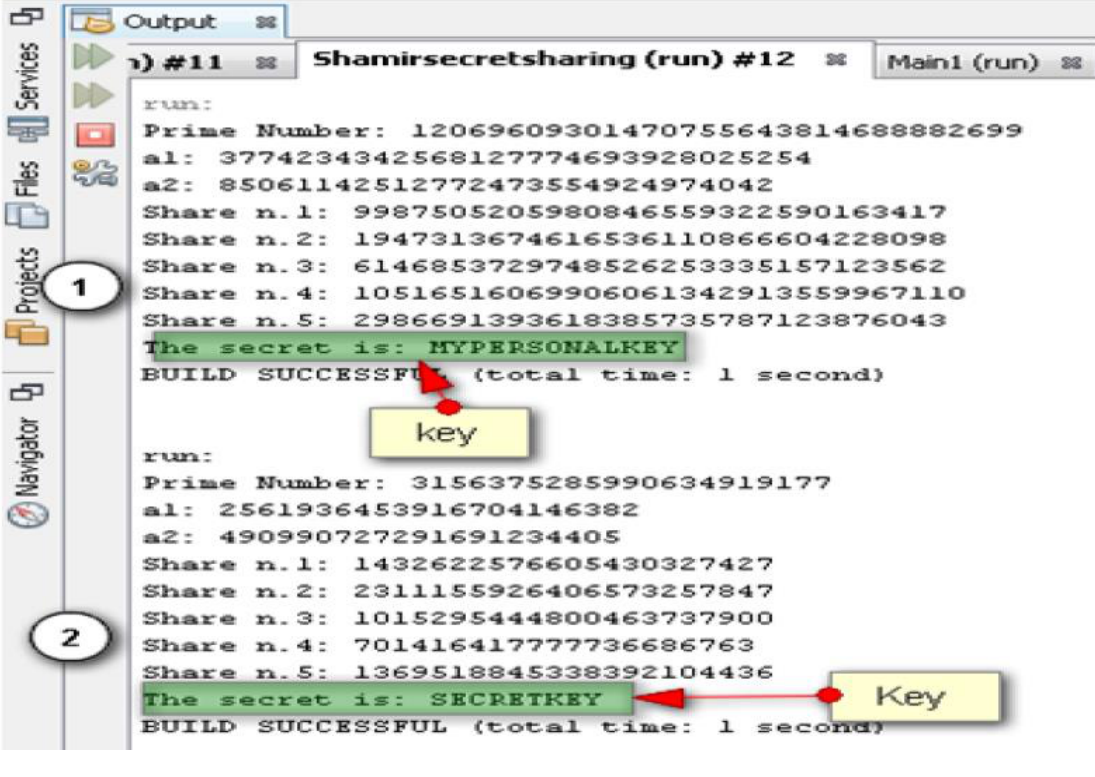
Figure 8 . Key Generator for Implementation 128 Bits